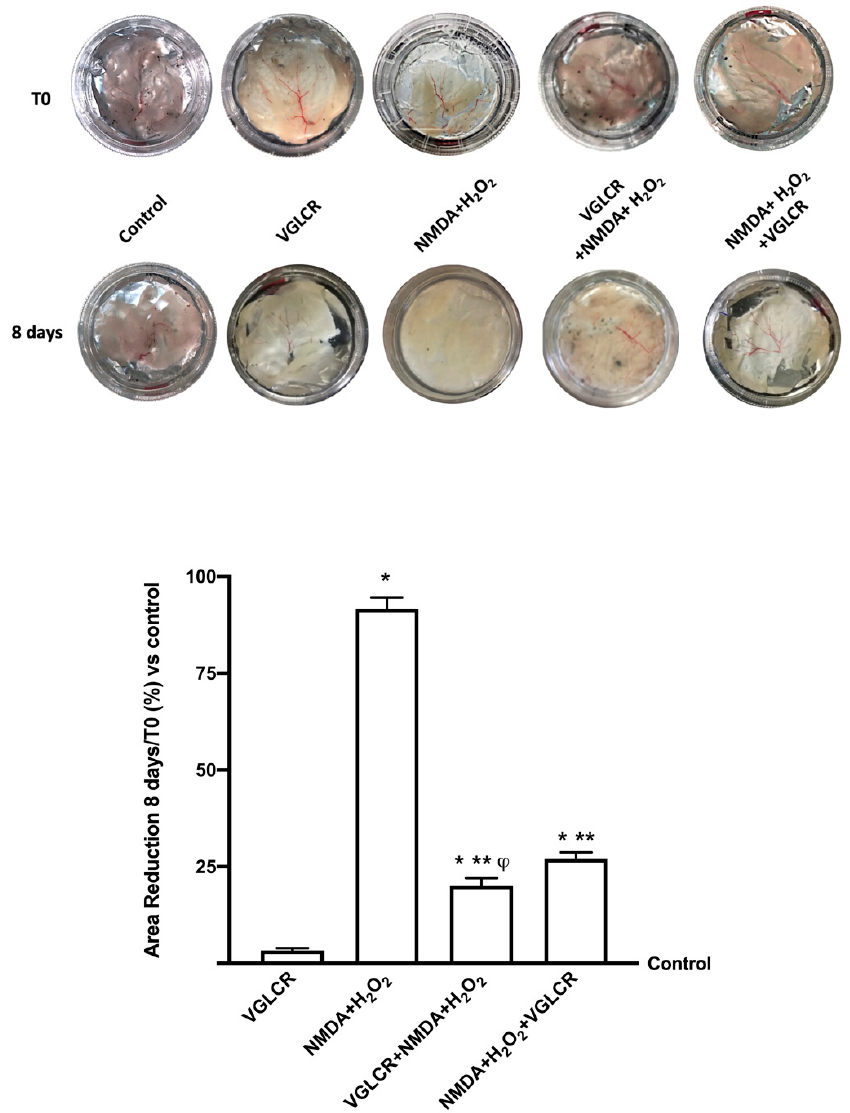
Figure 5. Morphological tissue and relative counting area on retinal tissues treated with NMDA and H 2 O 2 added together, and before and after VGLCR stimulations. The results are expressed as a reduction area normalized on T0 and the control quantified by ImageJ software, expressed as means ±SD (%) of 4 independent experiments, reproduced in duplicates. * p < 0.05 vs. control; ** p < 0.05 vs. Figure 1.